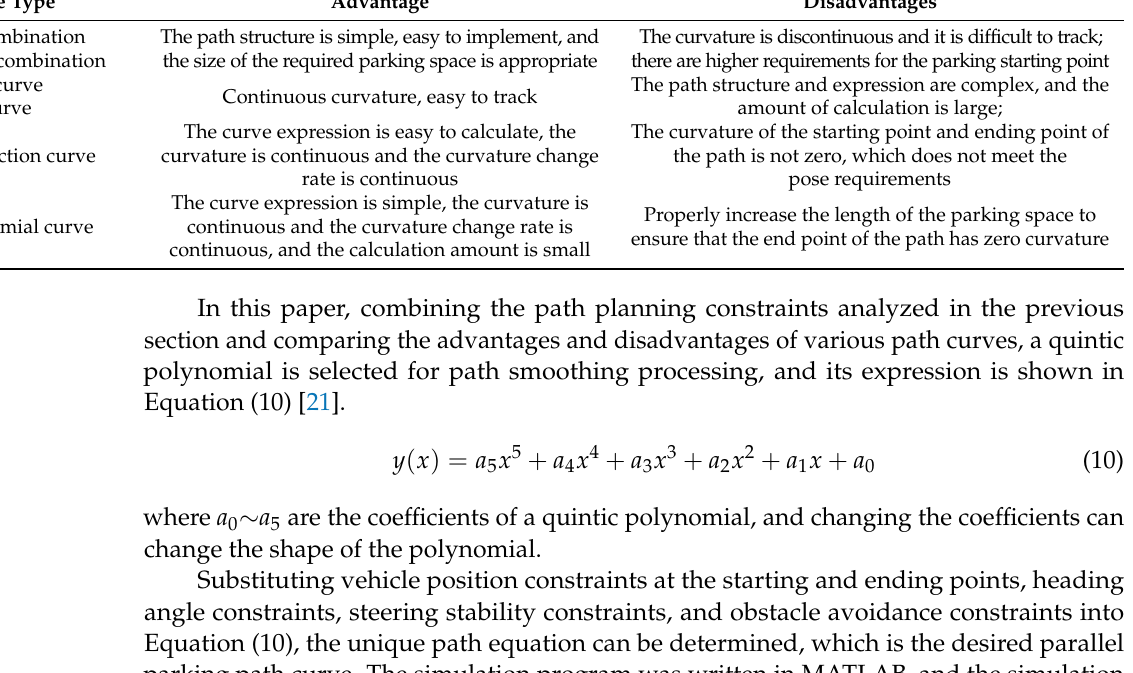
Table 2. Comparison of advantages and disadvantages of different path curves. Path Curve Type Double arc combination Arc-straight arc